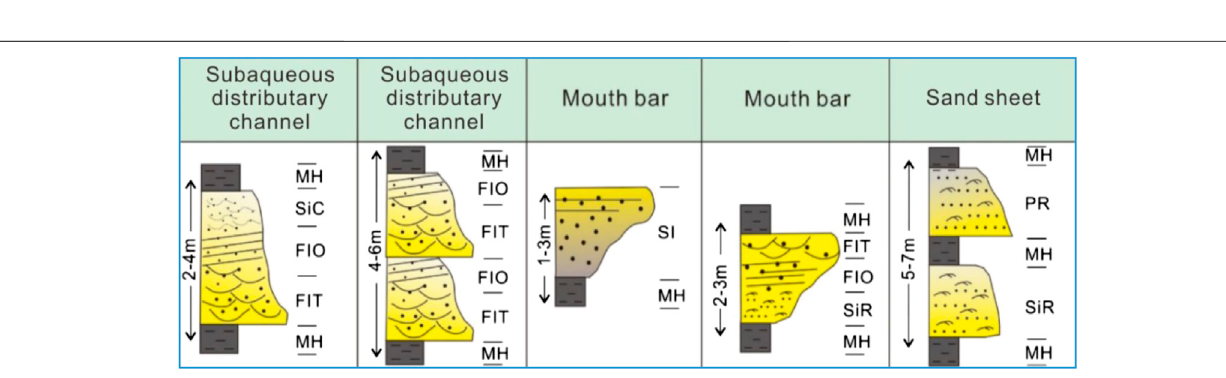
Frontiers in Earth Science |